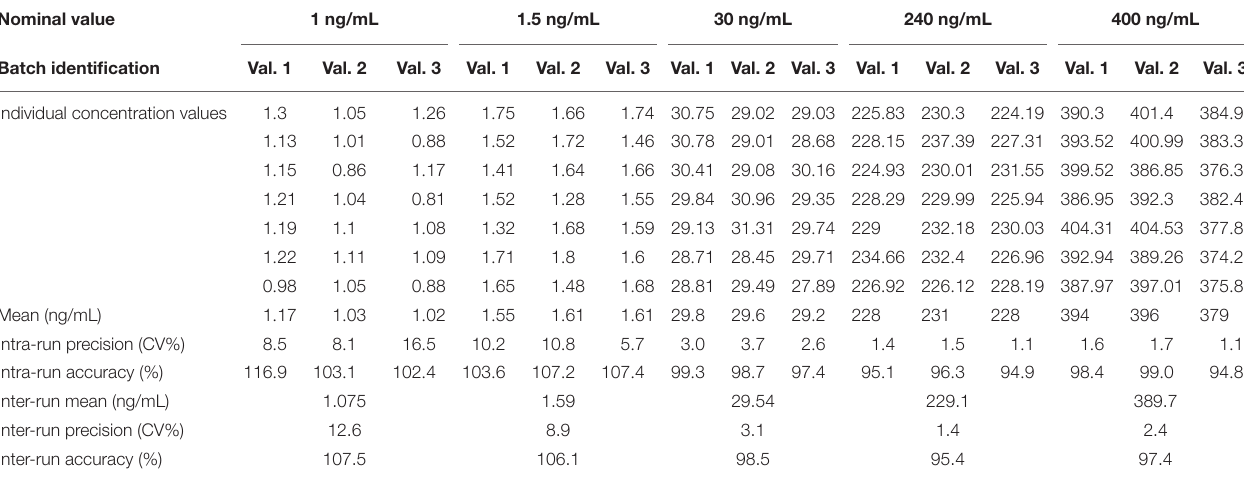
TABLE 1 | Accuracy and precision data for neurounina-1 from the pre-study validation in beagle dog plasma. Nominal value